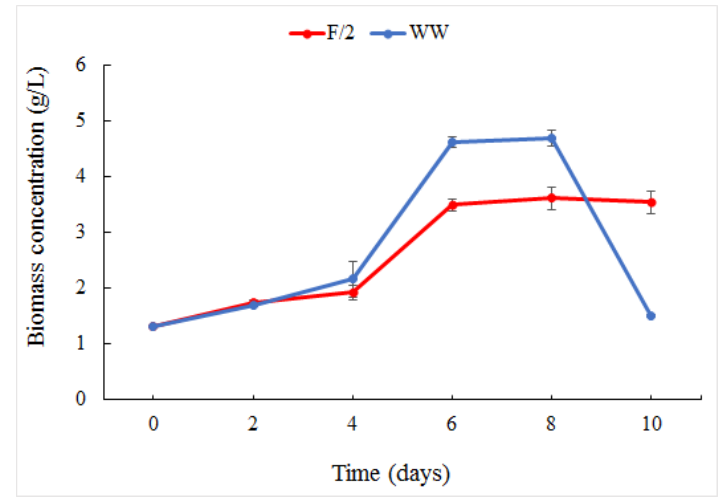
Figure 5. Changes in biomass concentration during cultures of Chlorella minutissima (mean ± SD; F/2— synthetic medium, WW—wastewater).